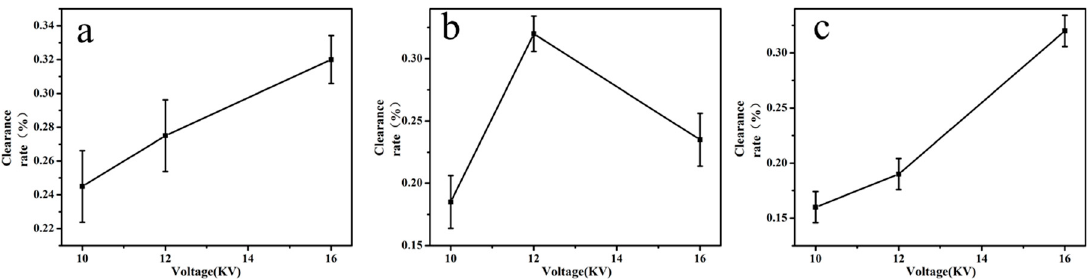
Figure 2. Impact of voltage on the clearance rate of active molecular membranes ( a : quercetin; b : Figure 2. Impactofvoltageontheclearancerateofactivemolecularmembranes( a : quercetin; b :glycyrrhizic; glycyrrhizic; c : α -mangostin). c : α -mangostin). Table 3. The impact of the voltage on the diameter of fiber. Table 3. The impact of the voltage on the diameter of fiber.